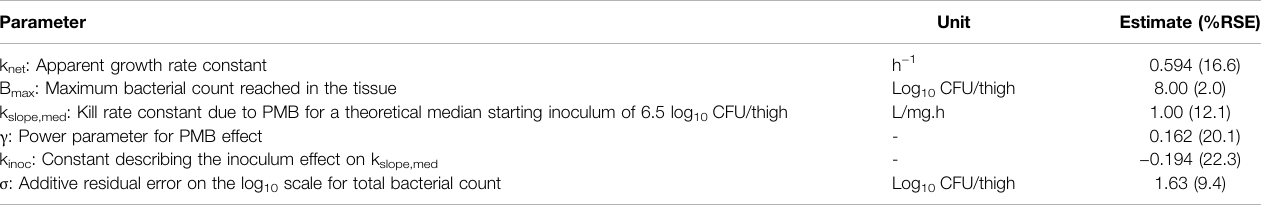
TABLE 2 | Parameter estimates and relative standard errors (RSE) for the fi nal PMB PKPD model. Parameter Unit